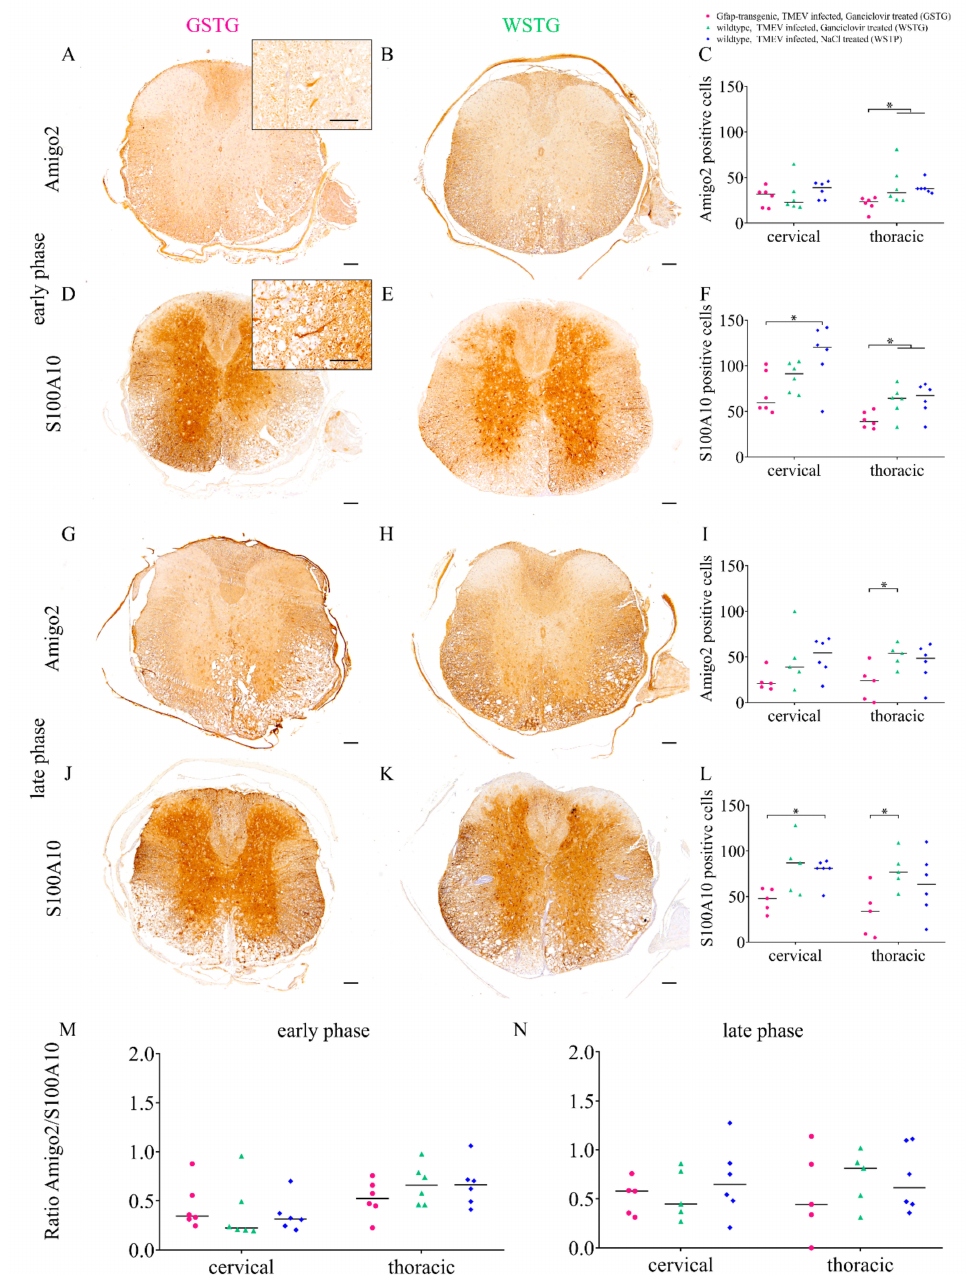
Figure 3. Astrocyte phenotype identification and quantification. Identification and quantification of astrocyte phenotypes in the ventral part of the spinal cord white matter were performed using immunohistochemistry identifying A1 (Amigo2, insert in A ) and A2 (S100A10, insert in D ). Astrocyte depletion resulted in a reduced number of Amigo2 positive cells in the thoracic spinal cord of TMEV infected, ganciclovir treated, Gfap -transgenic mice (GSTG) mice at 46 days post infection (dpi; A – C ) and 77 dpi (late phase; G–I ). Immunohistochemistry for S100A10 (A2 astrocytes) detected a significant reduction of the A2 subpopulation in the cervical and thoracic spinal cord at 46 dpi (early phase; D – F ) and 77 dpi (late phase; J – L ). Statistical analysis did not reveal a significant difference between the ratios of A1 and A2 astrocytes in all investigated groups. However, at 46 dpi ( M ) and 77 dpi ( N ) a variable predominance of A2 astrocytes in all groups was observed. Data are shown as scatter dot plots. Significant differences between the groups obtained by Kruskal–Wallis test followed by Mann–Whitney U post hoc tests were indicated by *, p < 0.05. Bars represent 100 µ m in overviews and 50 µ m in the